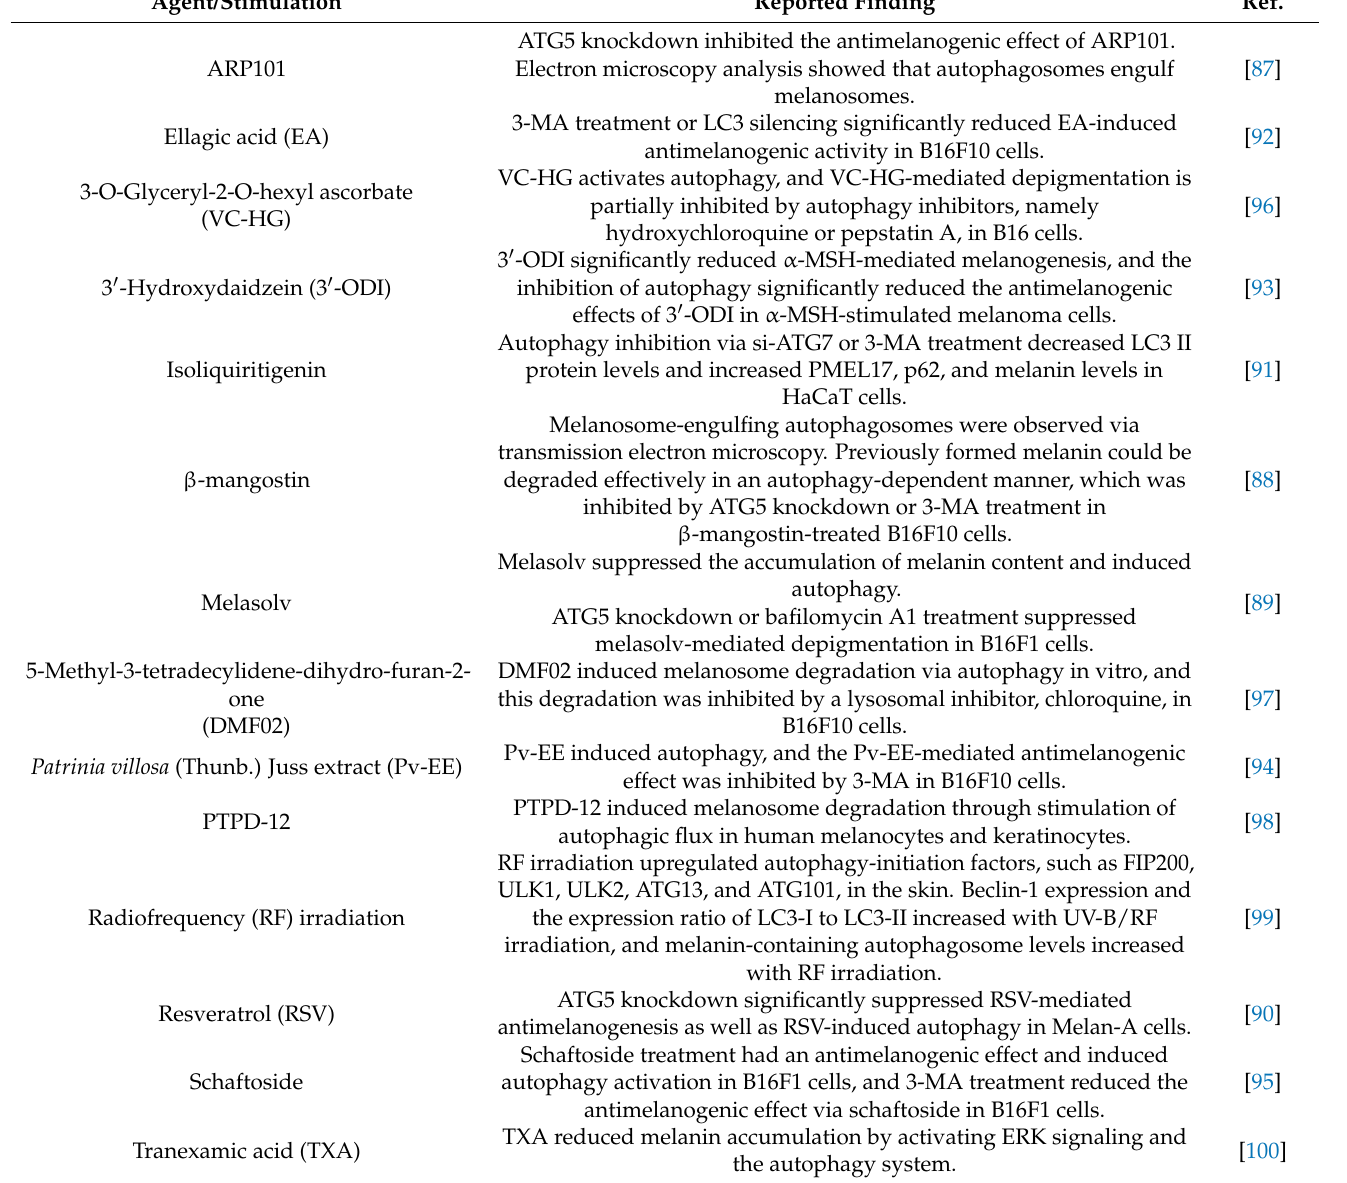
Table 1. Agents that induce skin depigmentation in an autophagy-dependent